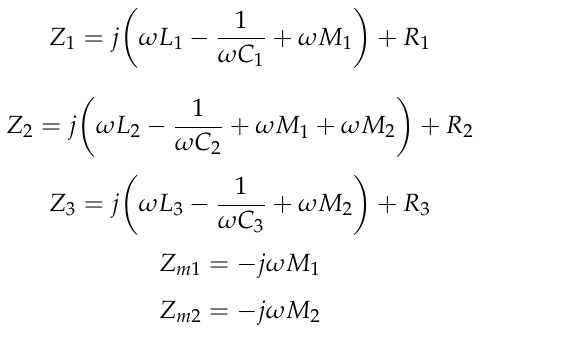
Figure 4. T-type equivalent circuit of the three-coil WPT system.